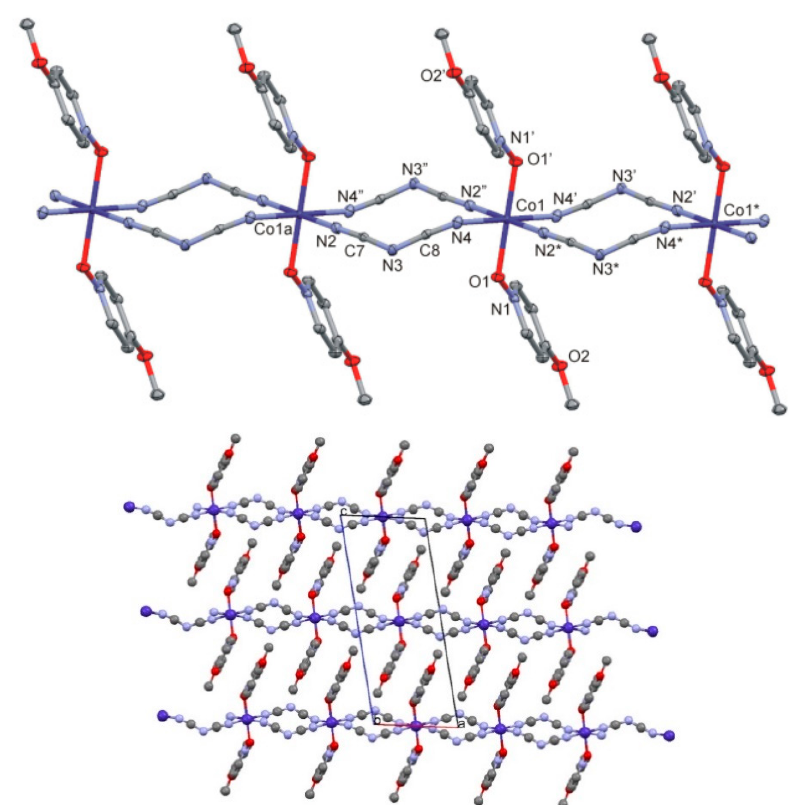
Figure 1. ( top ) One dimensional (1D) chain system of 1 . Symmetry operations: (’) 1-x,2-y,1-z; (”) 2-x,2-y,1-z; (*)-1+x,y,z; (a) 1+x,y,z; ( bottom ) packing plot of 1 .